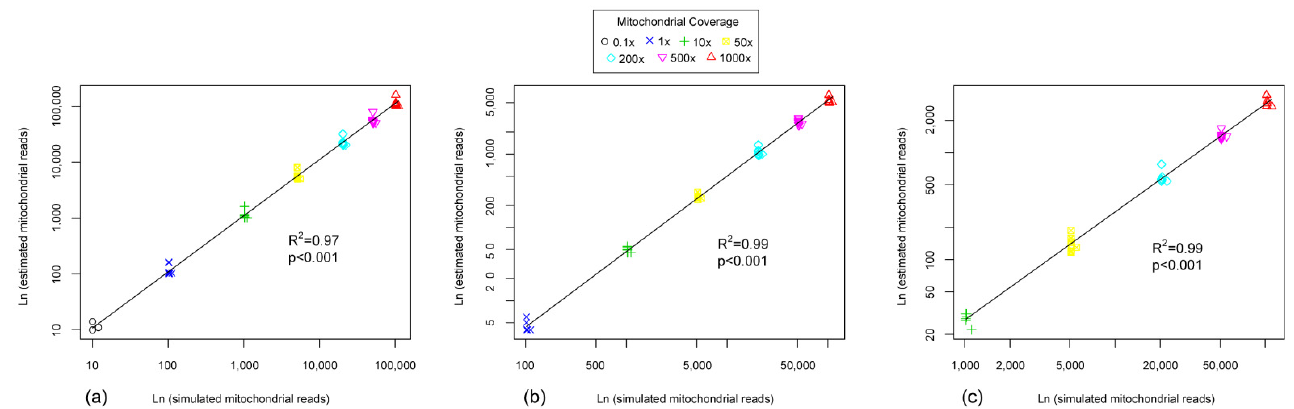
Figure A1. Assessing species abundance (read numbers) at varying mitochondrial coverage against mitogenome ( a ), COI ( b ), and mini-COI ( c ) references, respectively.